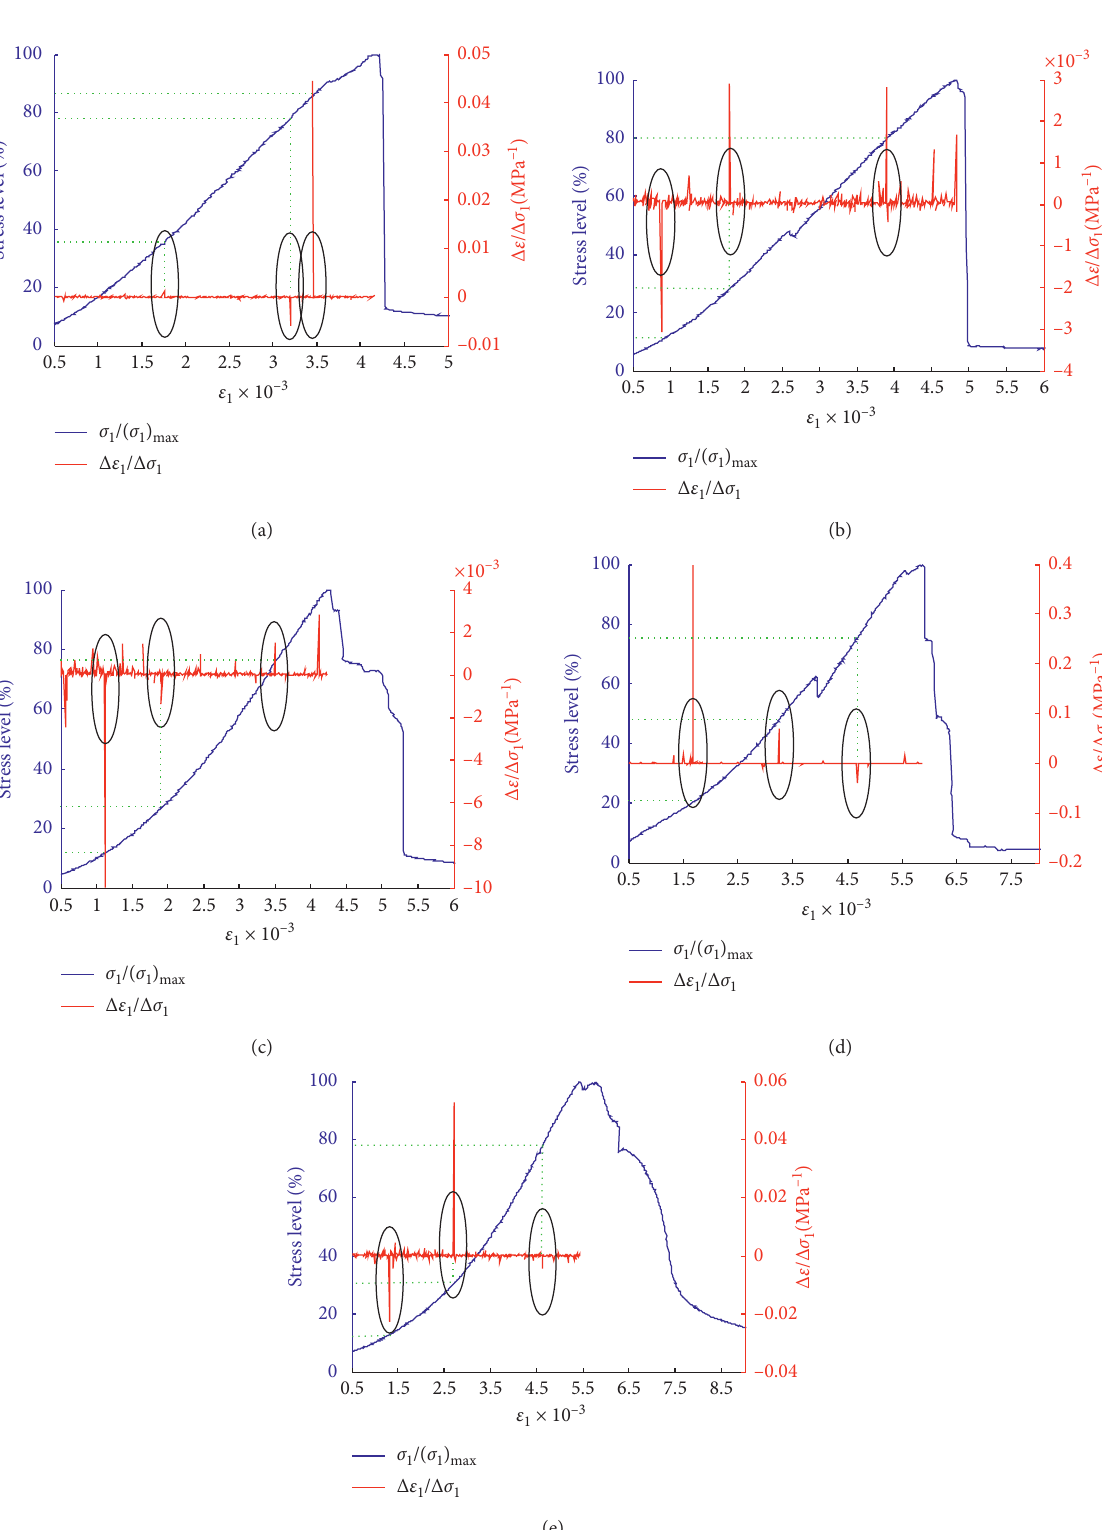
Figure 5: Evolution curve of the increment ratio of strain to axial pressure. (a) 25 ° C, (b) 200 ° C, (c) 400 ° C, (d) 600 ° C, and (e) 800 °